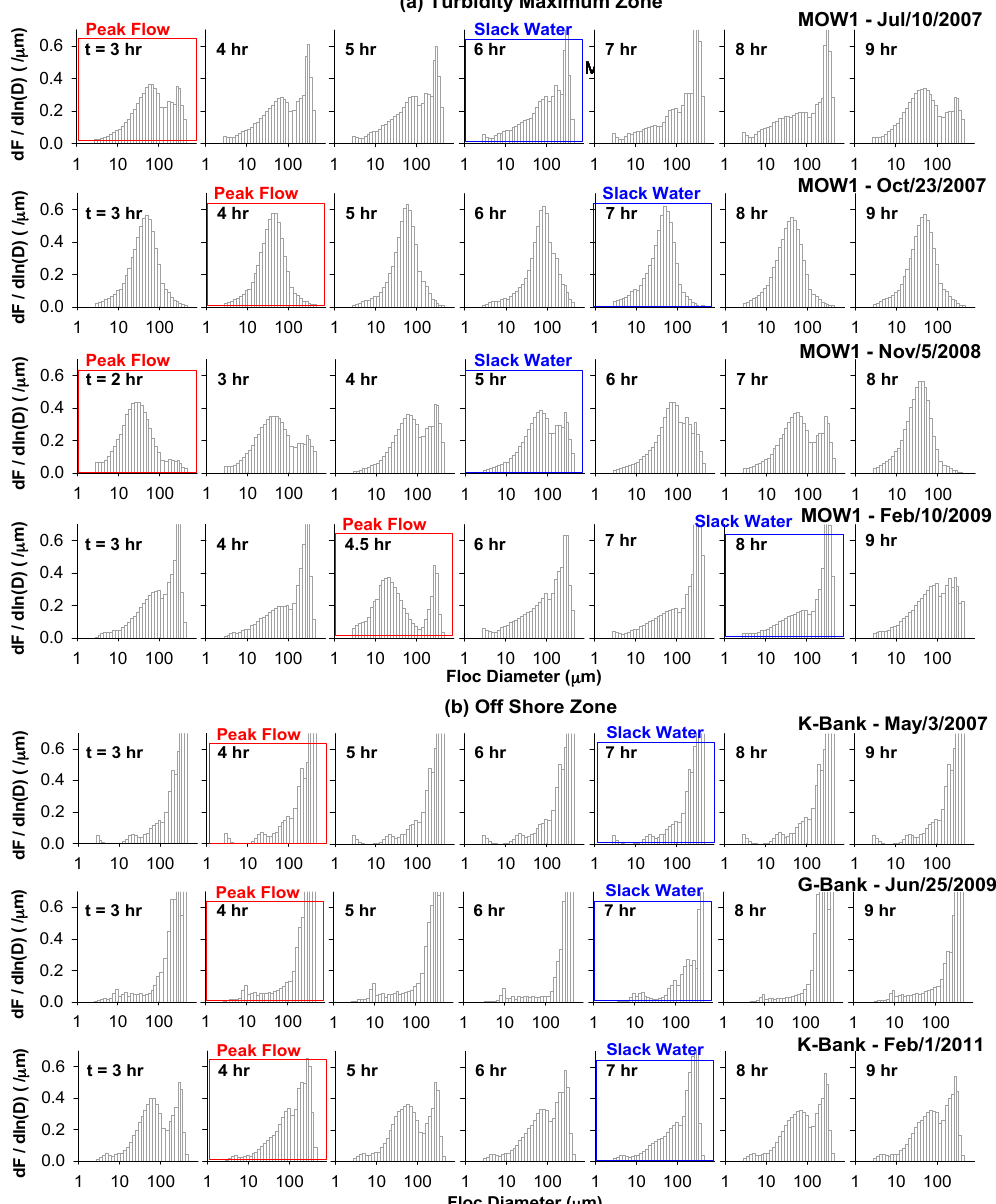
Figure 5. Particle size distributions (PSDs) of suspended particulate matter (SPM) in 13-h tidal cycles, for ( a ) the turbidity maximum zone (TMZ) (MOW1) and ( b ) the offshore zone (OSZ) (K-Bank and G-Bank). Each set of the PSDs was measured on a specific date of a field campaign. Each PSD was plotted on a logarithmic scale, and the fraction of a size bin was normalized by the width of the size bin in y-axis. Thus, dF/dln (D) is the normalized volumetric fraction by the width of the size interval in the log scale, in accordance with the lognormal distribution function [5,47].